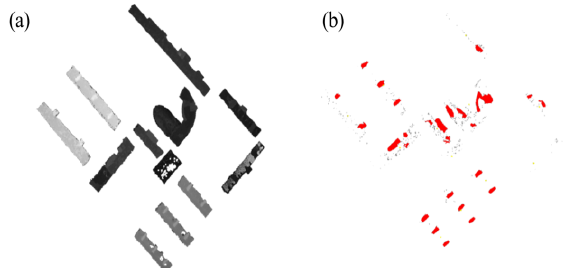
Figure 8. Ortho image(a) and detailed structure area(b).